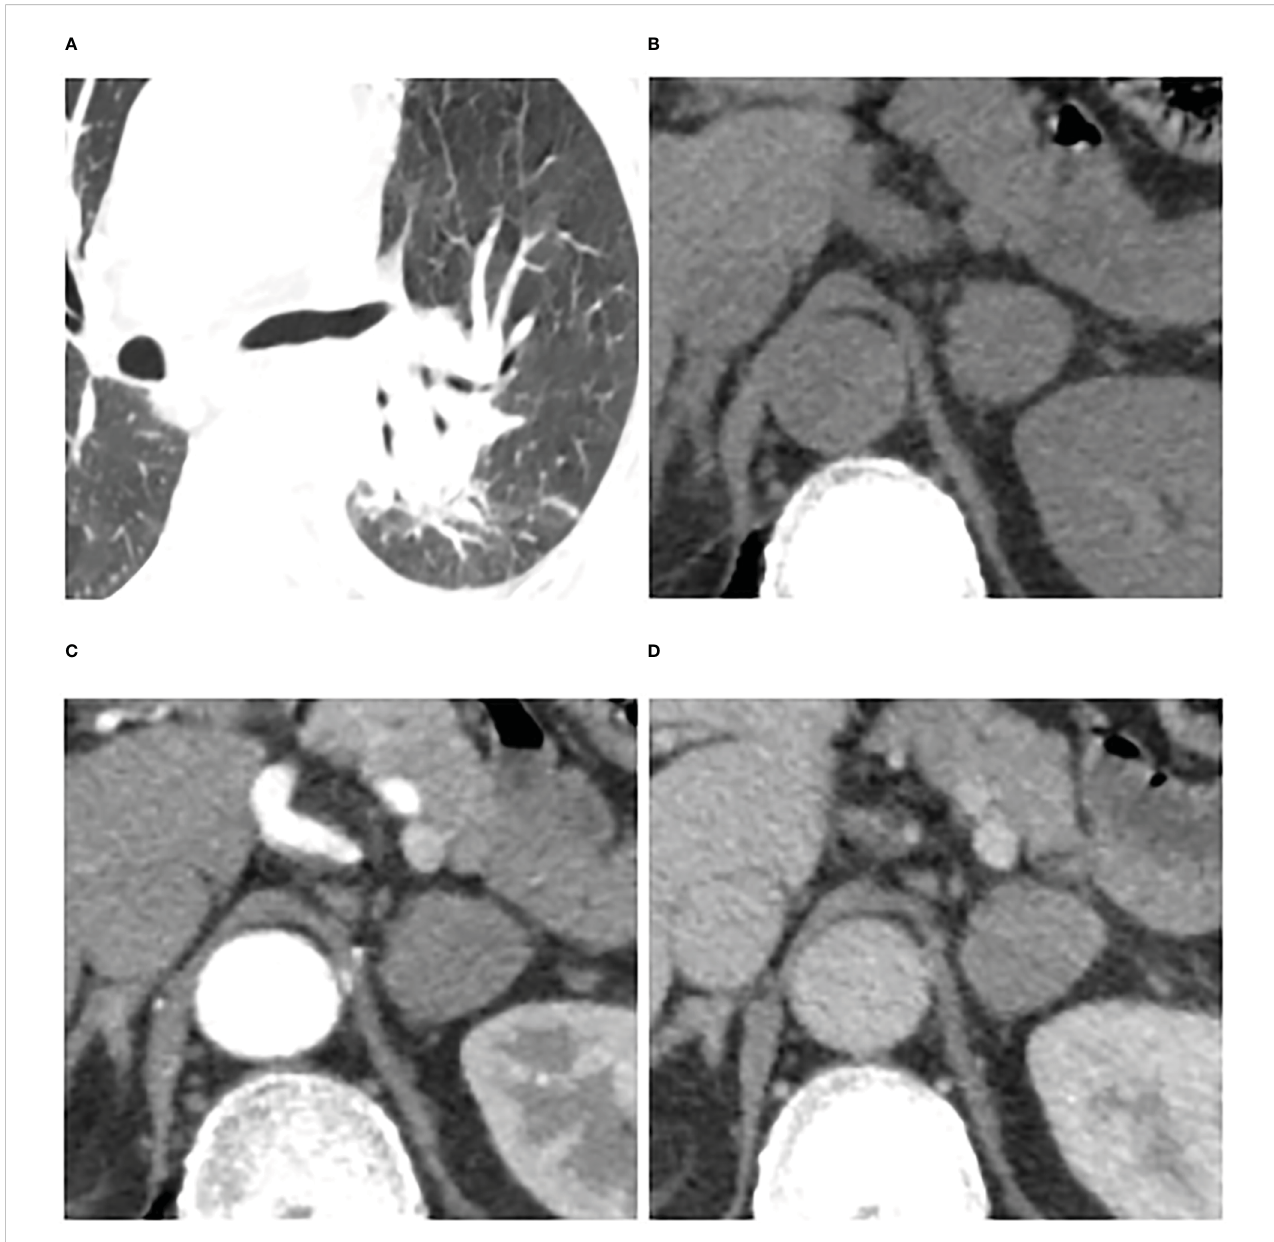
FIGURE 6 Adrenal metastases in a 66-year-old man. Pulmonary window of primary small-cell lung cancer (stage IV) (A) and unenhanced phase (B) , arterial phase (C) , and venous phase (D) of adrenal nodular showed a 25 mm × 23 mm tumor in left adrenal. Attenuation values on unenhanced, arterial, and venous phase were 36, 65, and 64 HU, respectively. The enhancement ratio on venous phase was 0.78. No cystic degeneration was seen within the nodular. Peak enhancement phase was equally enhanced. The nodular got a score of 12 points, indicating diagnosis of